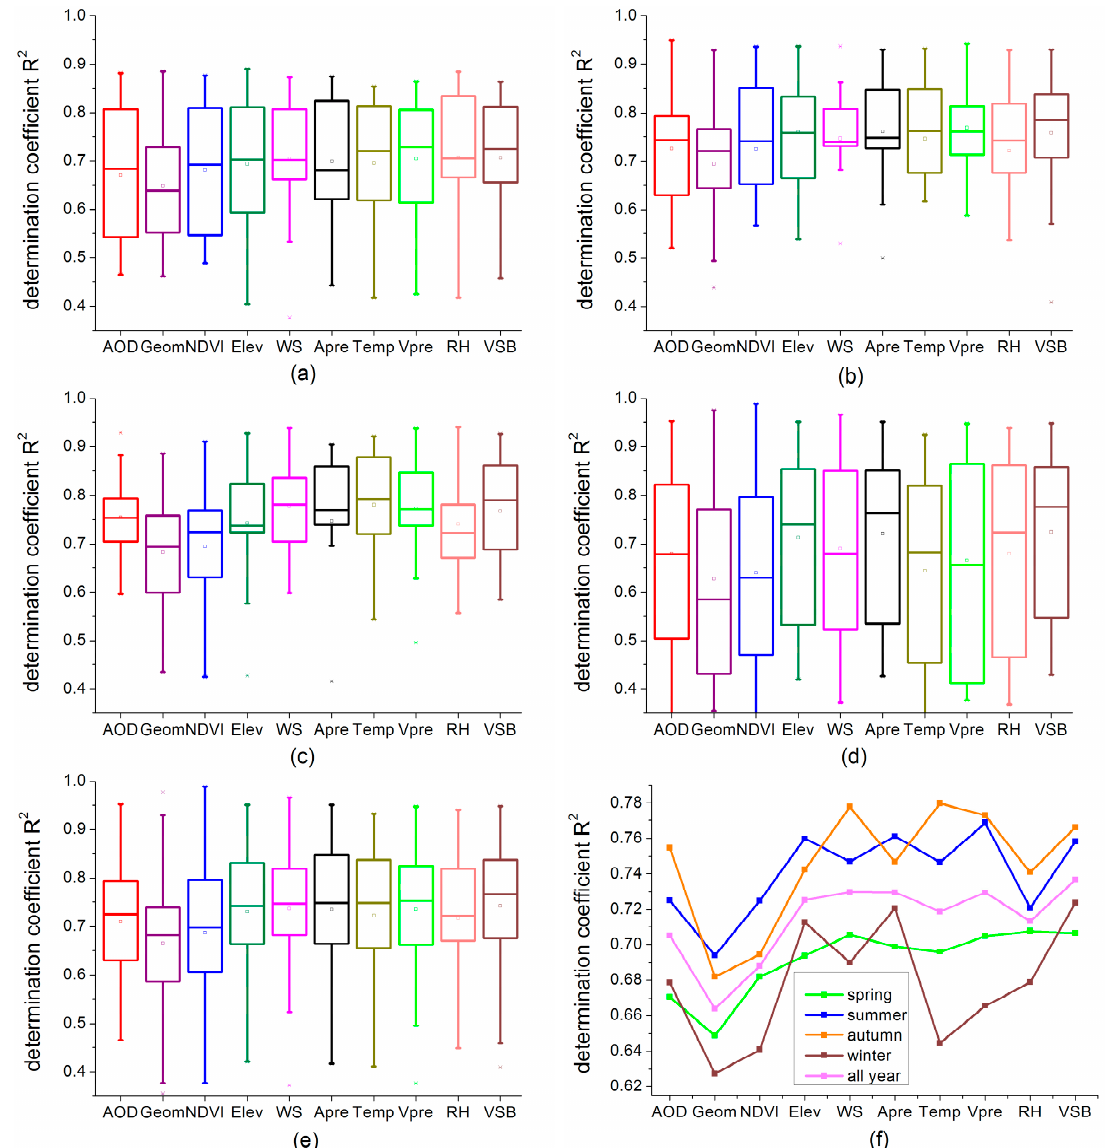
Figure 3. Contributions from nine auxiliary variables in GWR modelling of four seasons and the whole year. ( a ) spring, ( b ) summer, ( c ) autumn, ( d ) winter, ( e ) whole year, ( f ) curve line of contributions from all auxiliary variables in four seasons and the whole year. The box gives the 25%–75% percentile and the line in the box denotes the median. The whisker is the maximum and minimum of R 2 , the points outside the box are outliers, inside the box an average of R 2 .